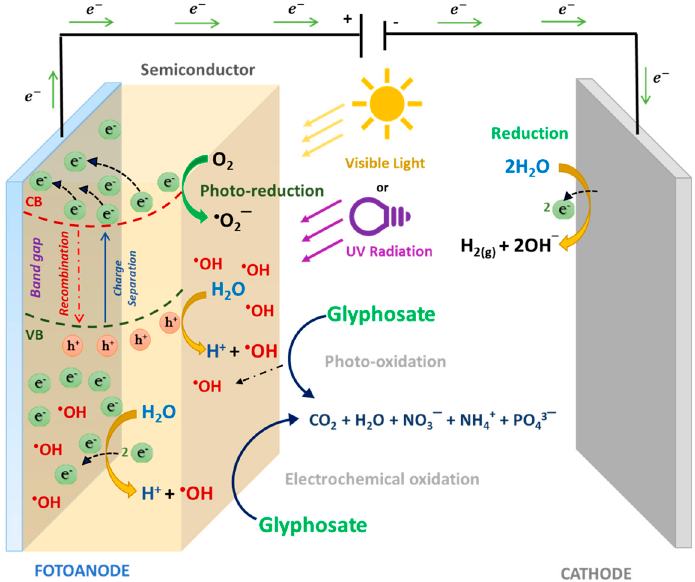
Figure 5. Schematic representation of the mechanism of photoelectrocatalysis applied to organic pollutants degradation.